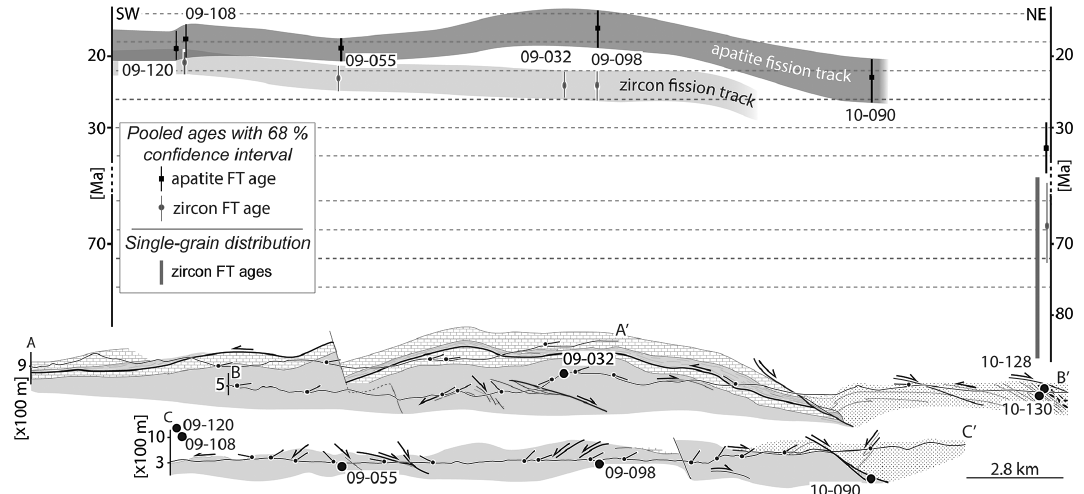
Figure 5. AFT and ZFT ages along three transects across the eastern Pelagonia gneiss dome. For the location of the transects see Fig. 2.